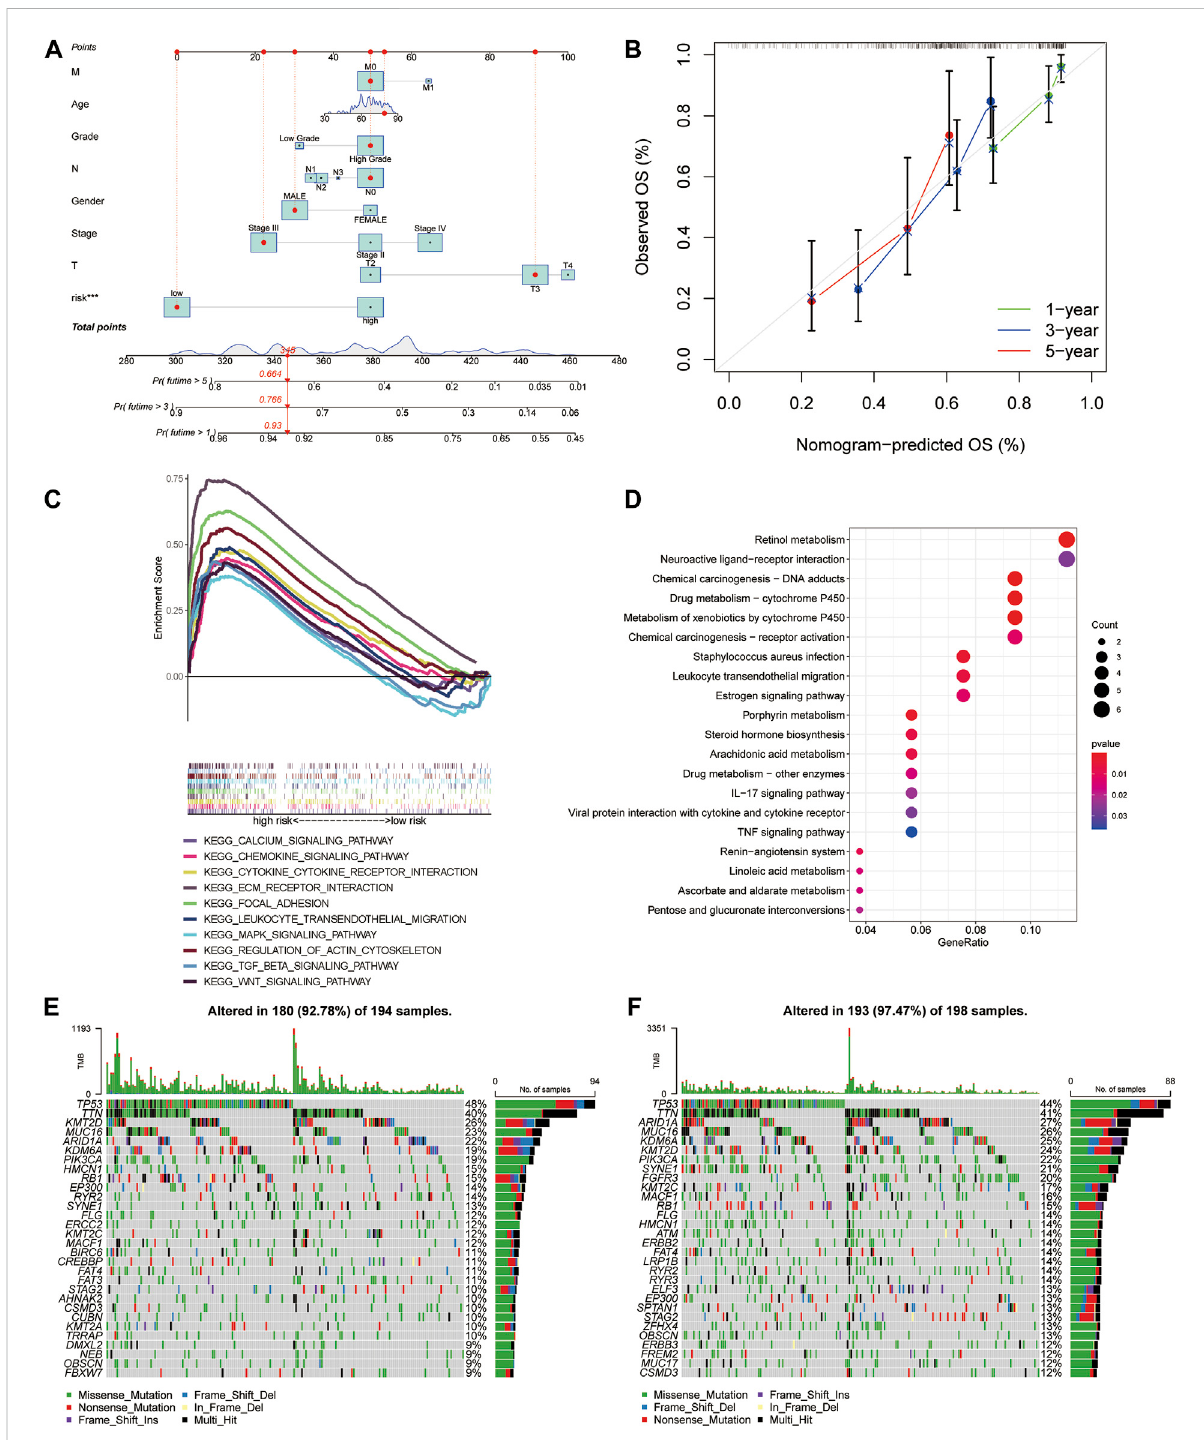
FIGURE 5 Construction and calibration of the nomogram, followed by functional and tumor burden analyses. (A) Nomogram integrated age, gender, grade, stage, T stage, N stage, M stage, and risk score. (B) Calibration curves test consistency of the nomogram at 1, 3, and 5 years. (C) Activated pathwaysanalyzedbygenesetenrichmentanalyses(GSEA)inthehigh-riskgroup. (D) KyotoEncyclopediaofGenesandGenomes(KEGG)analysisof differential genes between high- and low-risk groups. (E,F) The gene mutations between high- and low-risk